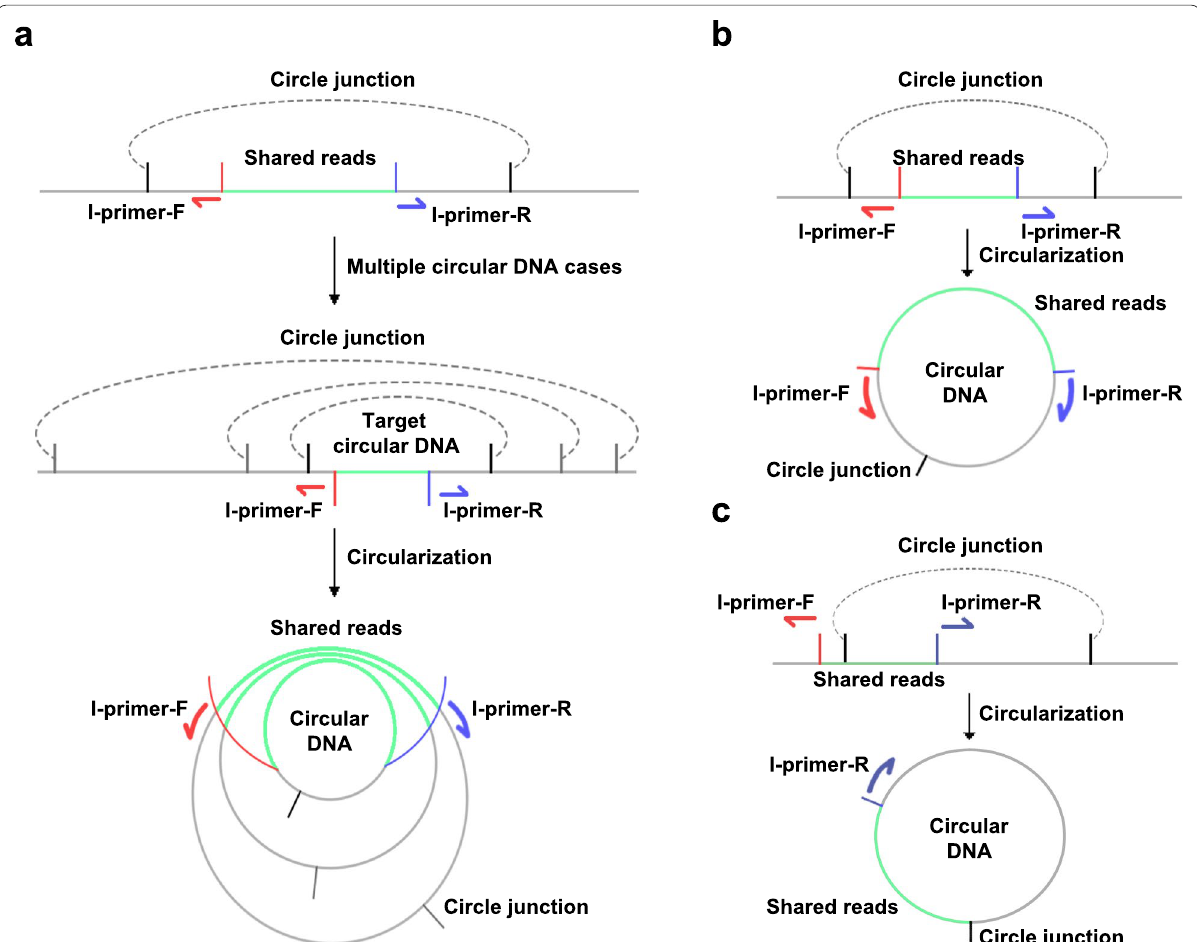
Fig. 6 The principle and deficiency of inverse PCR for verifying eccDNAs. a Schematic representation of inverse PCR being off-target. b-c Schematic representation of inverse PCR failing to detect junction